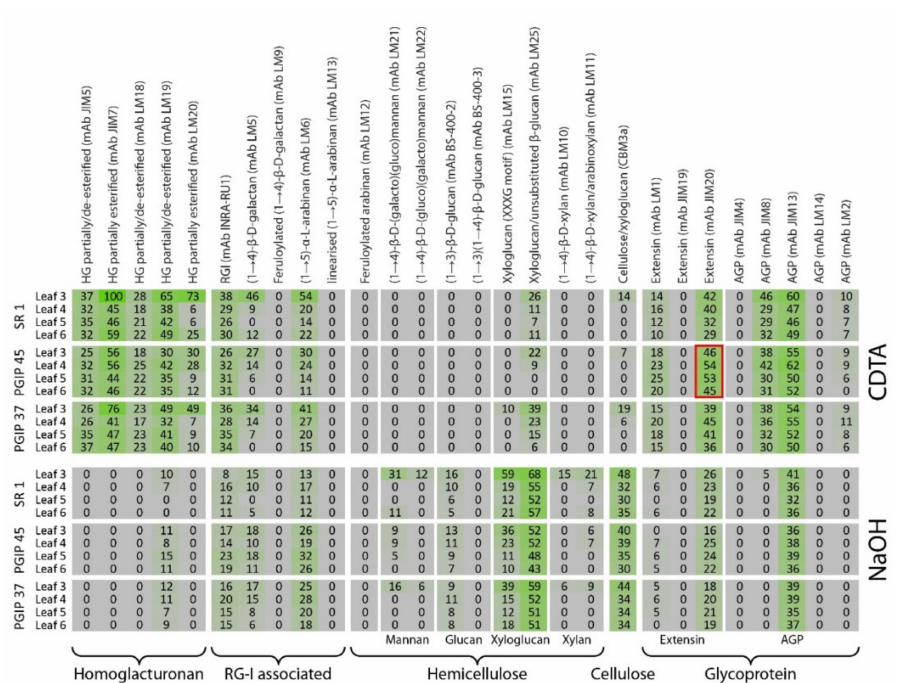
Figure 6. CoMPP of the wild type SR1, PGIP37, and PGIP45 tobacco leaf AIR. Heatmap showing cell wall polysaccharides and proteins relative abundance using antibodies signal intensity reads, presented results are from the average of four biological